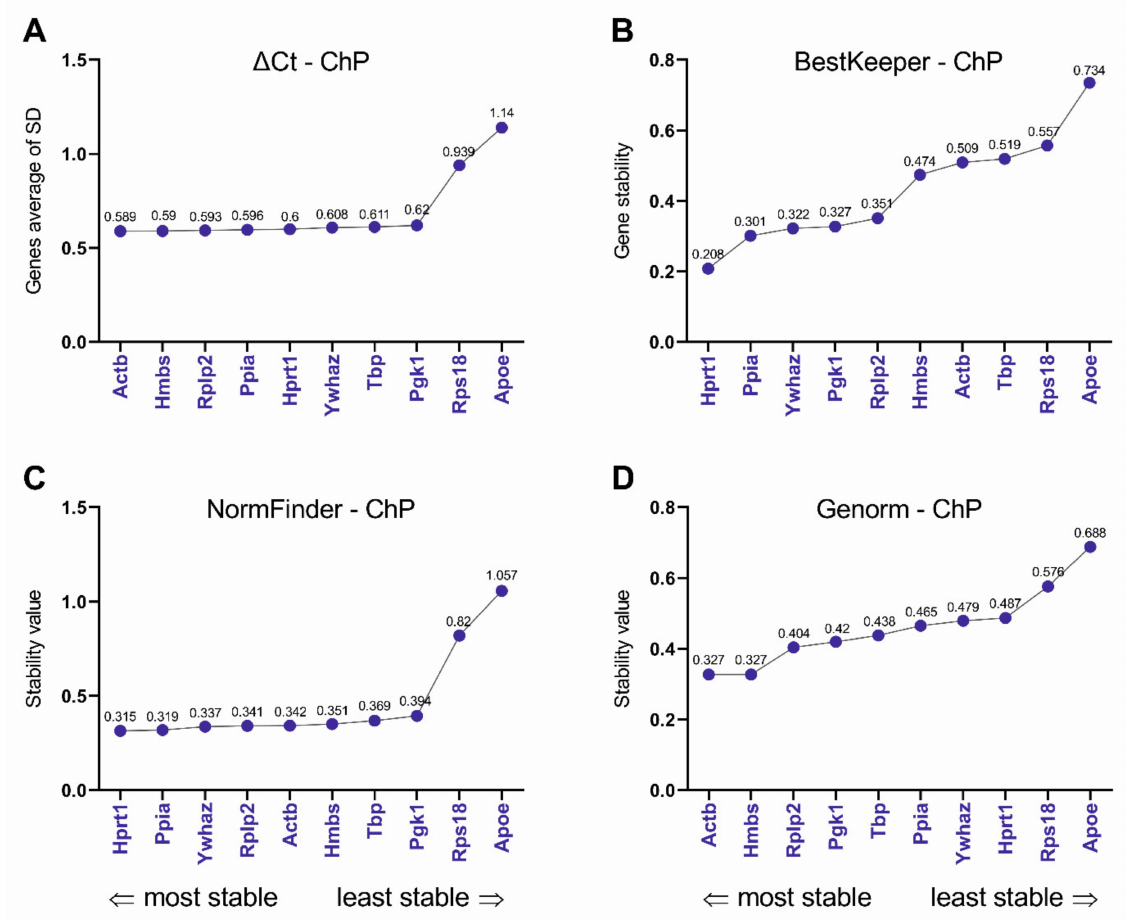
Figure 6. Expression stabilities and ranking of reference genes in the choroid plexus (ChP; n = 6, 6 females/3 samples and 6 males/3 samples for each time point) according to the ∆ Ct ( A ), BestKeeper ( B ), NormFinder ( C ), and Genorm ( D ) algorithms. Ranking calculated using